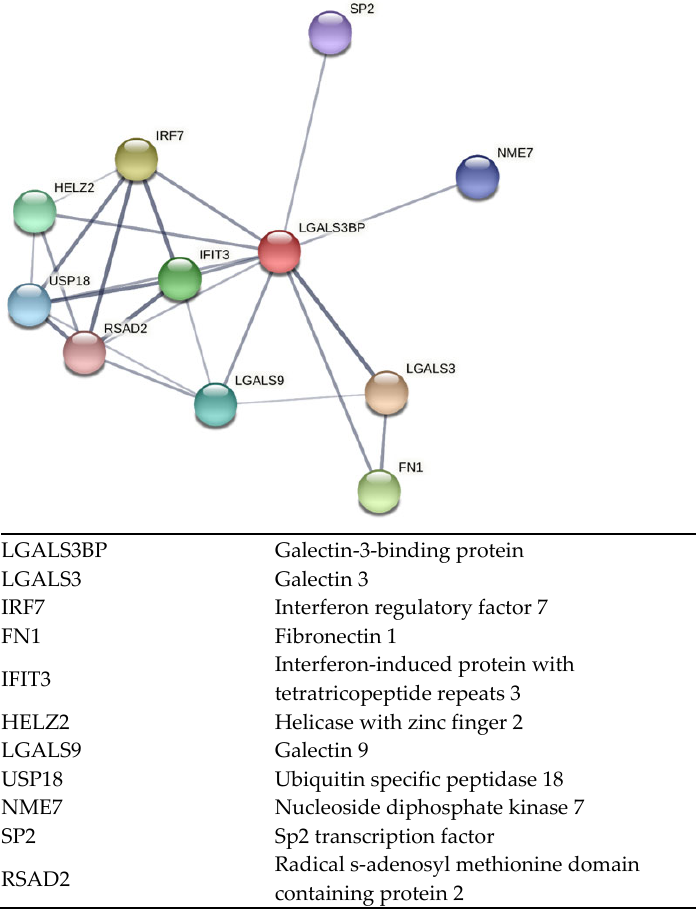
Figure 1. Interactive network of predicted protein–protein associations with LGALS3BP in the domestic cat species. Edges represent both physical and functional protein associations (STRING 11.5).